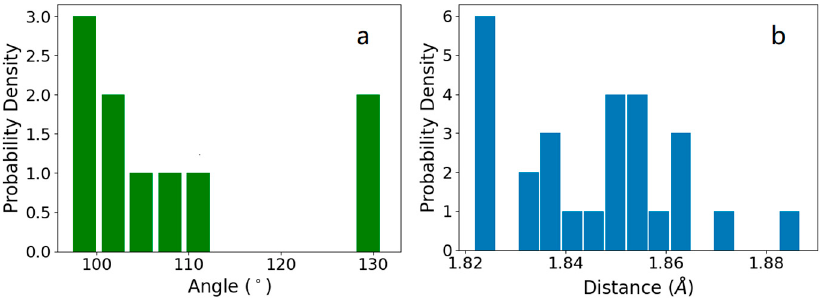
Figure 4. ( a ) Distribution of the included angles between HBs in ice III. ( b ) Distribution of the HB lengths in the ice III supercell. lengths in the ice III